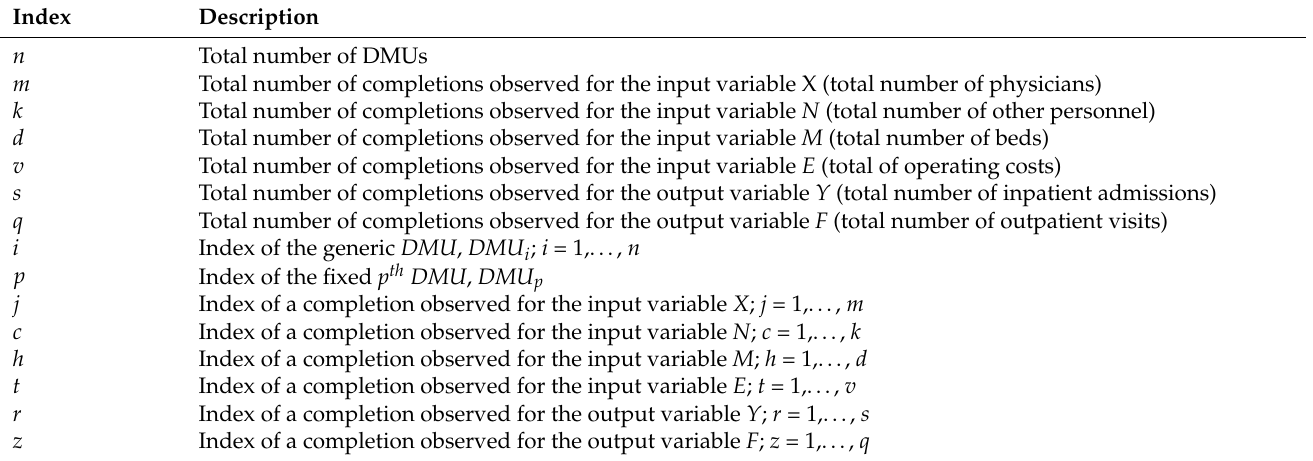
Table 3. Explanation of the parameters for primal and dual BCC IO -CCR IO